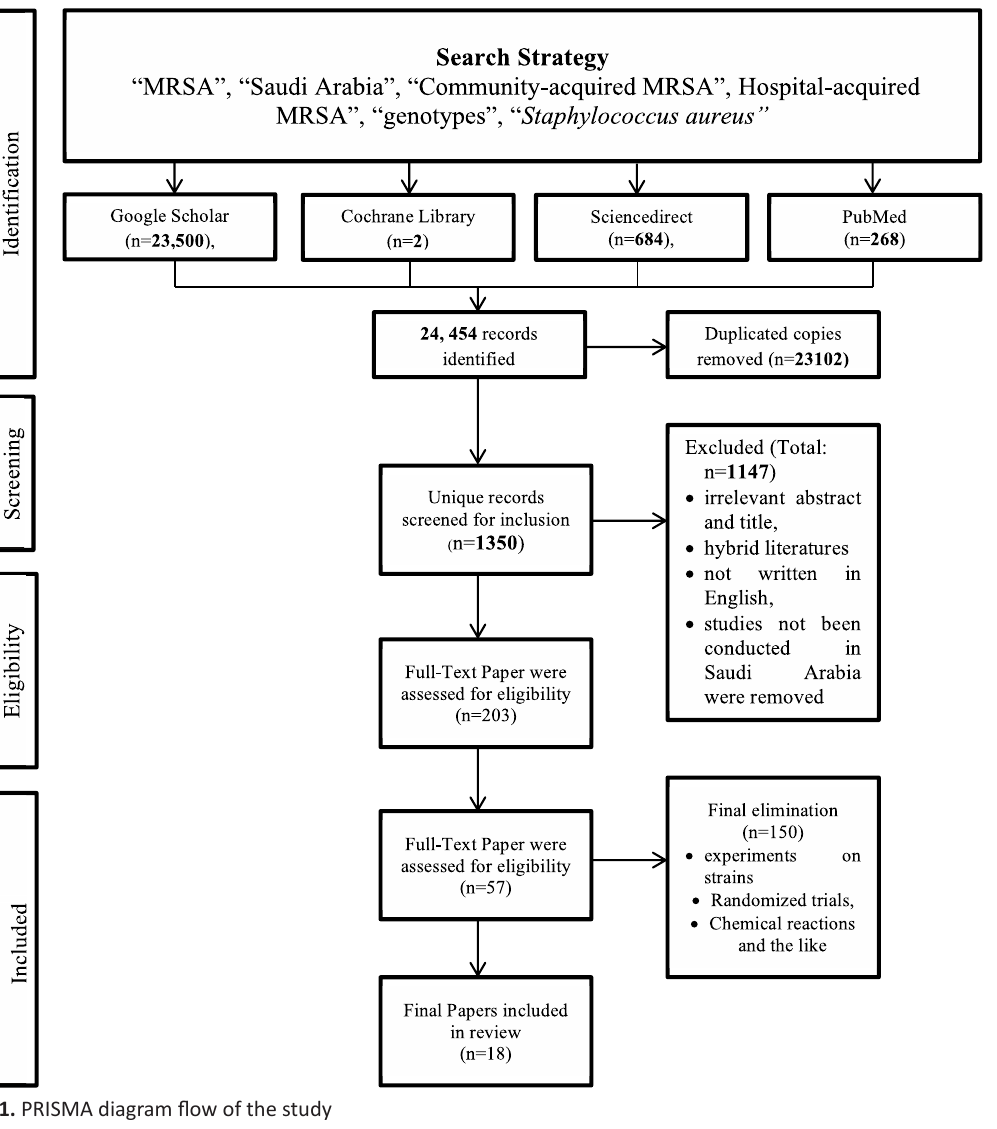
Fig.1. PRISMA diagram flow of the